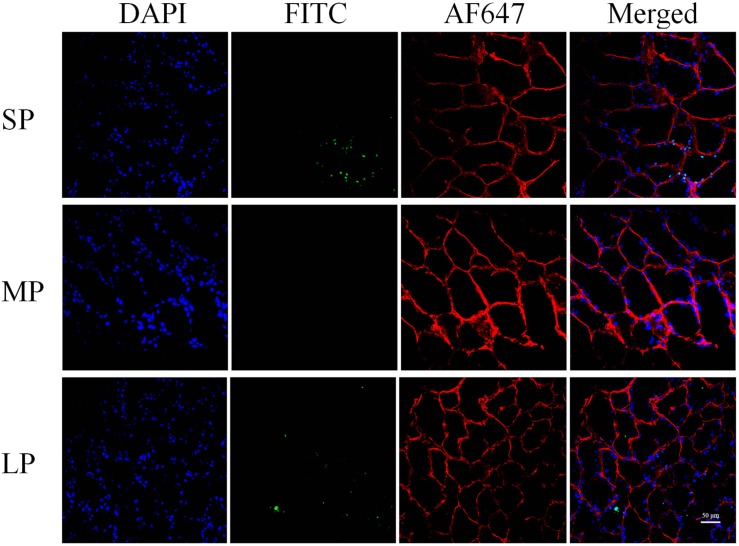
Fluorescent terminal deoxynucleotidyl transferase biotin-dUTP nick end labeling (TUNEL) staining of HG in hamsters in three photoperiodic groups. Immunofluorescence histochemistry showing cell apoptosis, cell boundaries, and nuclei. Blue represents 4′6′-diamidino-2-phenylindole (DAPI)-stained nucleus, red represents Alexa Fluor 647-stained laminin of interstitial tissue, green represents TUNEL by FITC. Scale bar = 50 μm. SP, short photoperiod; MP, moderate photoperiod; LP, long photoperiod.